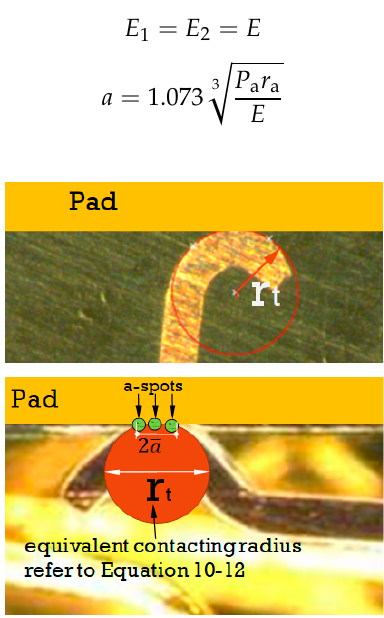
Figure 16. Schematic representation of a contact tip design. Appl. Sci. 2019 , 9 , x